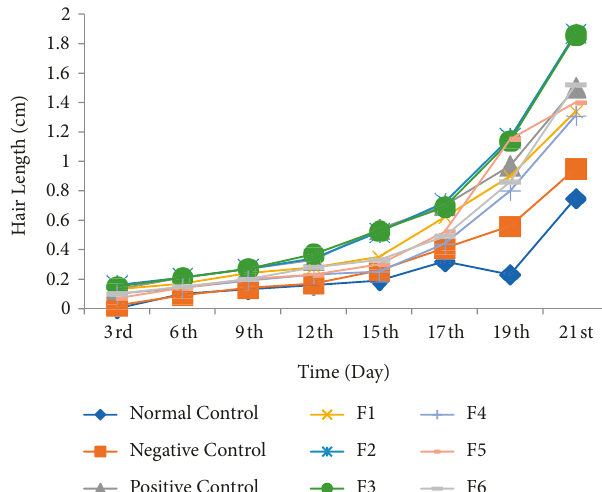
Figure 2: Test of liquid vacuum chromatography fractions of M. peltata leaf ethyl acetate